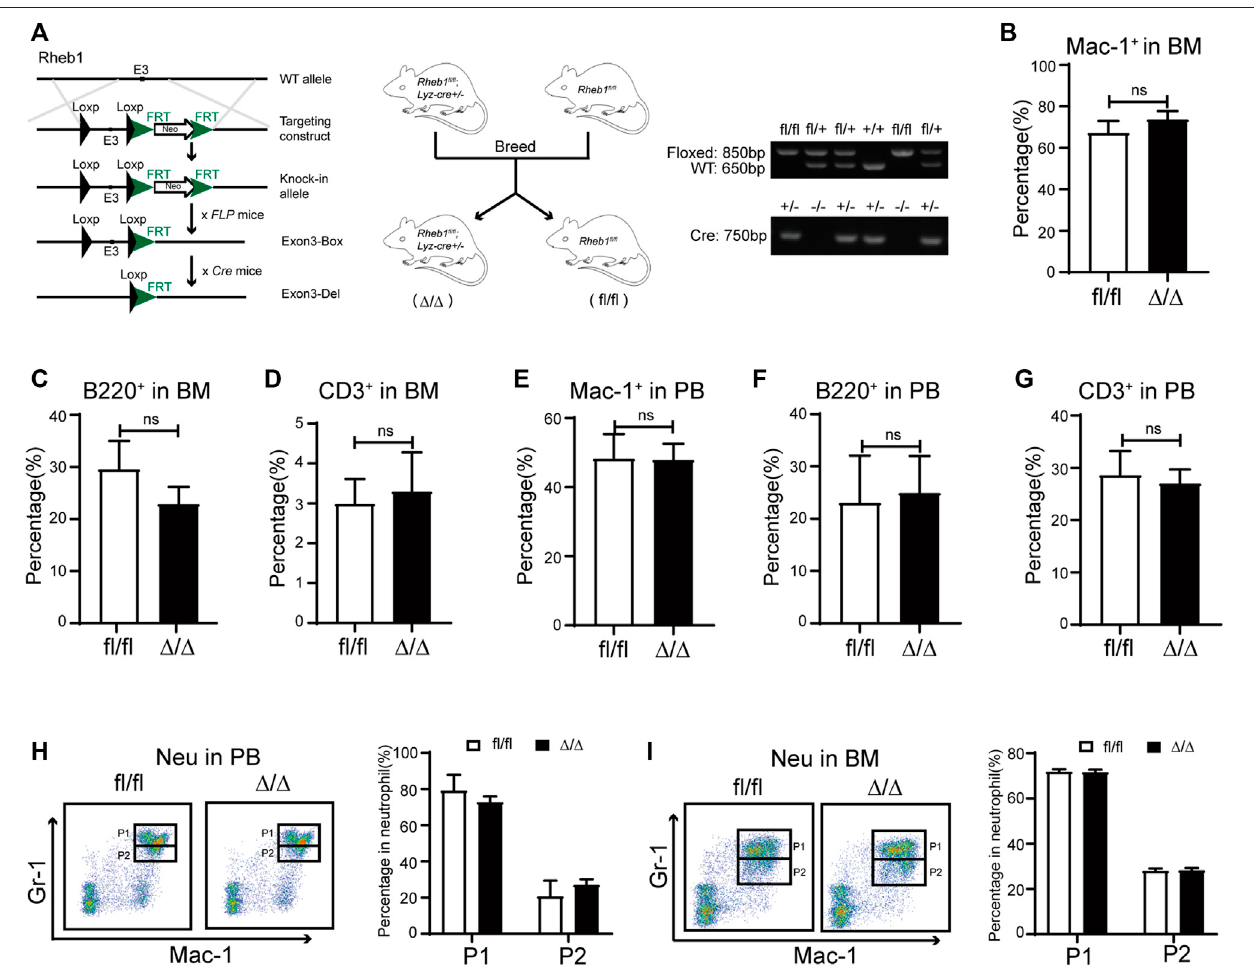
FIGURE 4 | Inhibiting mTORC1 signaling in myeloid cells didn ’ t in fl uence its proliferation and differentiation (A) Mice model of Lyz-cre; Rheb1 fl / fl mice ( Rheb1 Δ / Δ ), speci fi cdeletion of Rheb1 in the myeloid cells (left and middle panel). The offspring were identi fi ed byPCR and analyzed by agarose gel. The size of fl oxed fragment was 850bpwhilewildtypewas650bp,andthe750bpsegmentwasampli fi edfrom Cre +/- (rightpanel) (B – D) PercentageofBcells,TcellsandmyeloidcellsinBMof Rheb1 fl / fl and Rheb1 Δ / Δ ;n=4 (E – G) PercentageofBcells, Tcellsand myeloidcellsinPBof Rheb1 fl / fl and Rheb1 Δ / Δ ;n=4 (H) FACSanalysisofneutrophilsinPBof Rheb1 fl / fl and Rheb1 Δ / Δ , n = 4 (I) FACS analysis of neutrophils in BM of Rheb1 fl / fl and Rheb1 Δ / Δ , n = 4.